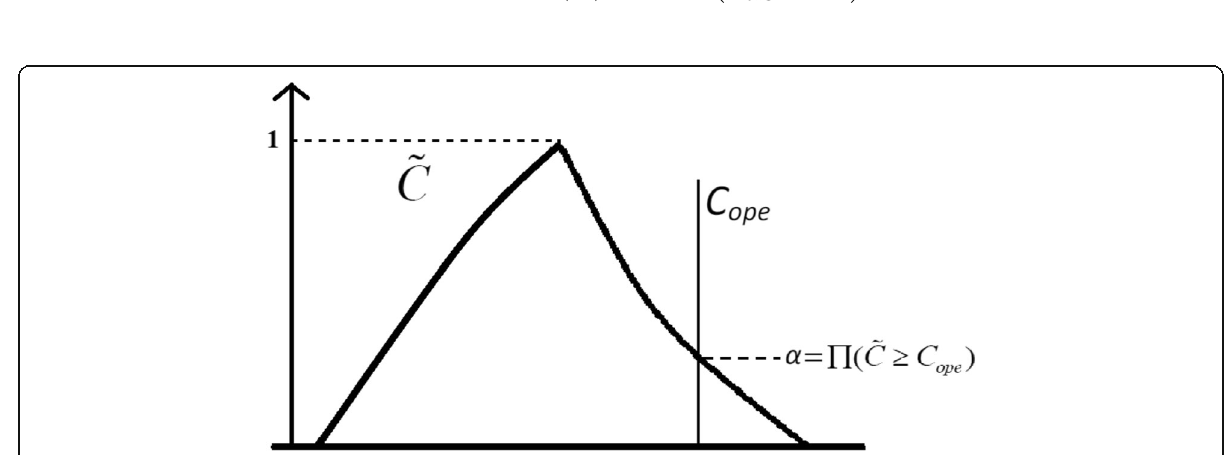
Fig. 3 Fuzzy maximum capacity compared to Operative Capacity C ope at the right